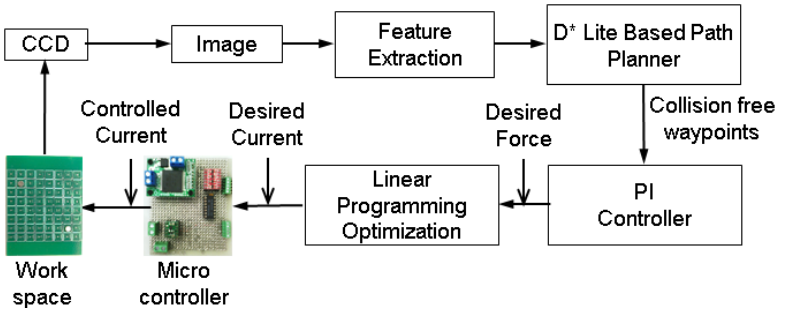
Figure 1. The overall approach: The approach consists of tight integration of perception, planning, control, and